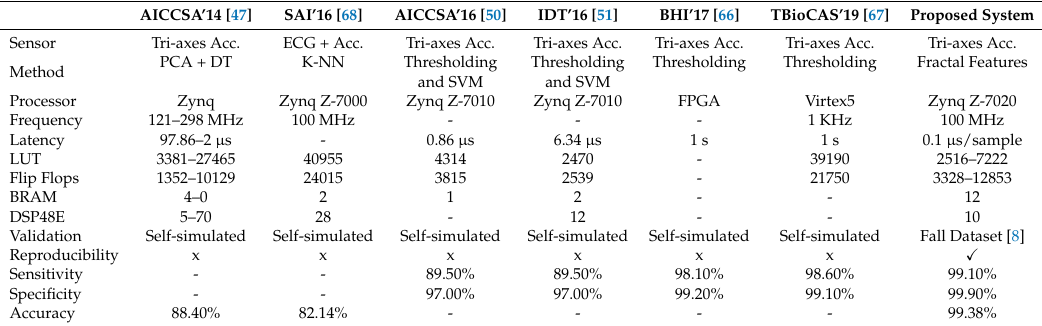
Table 7. Proposed algorithm system comparison with current comparable work. Tri-axes Acc. ECG + Acc. Tri-axes Acc. Tri-axes Acc. Tri-axes Acc. Tri-axes Acc. Tri-axes